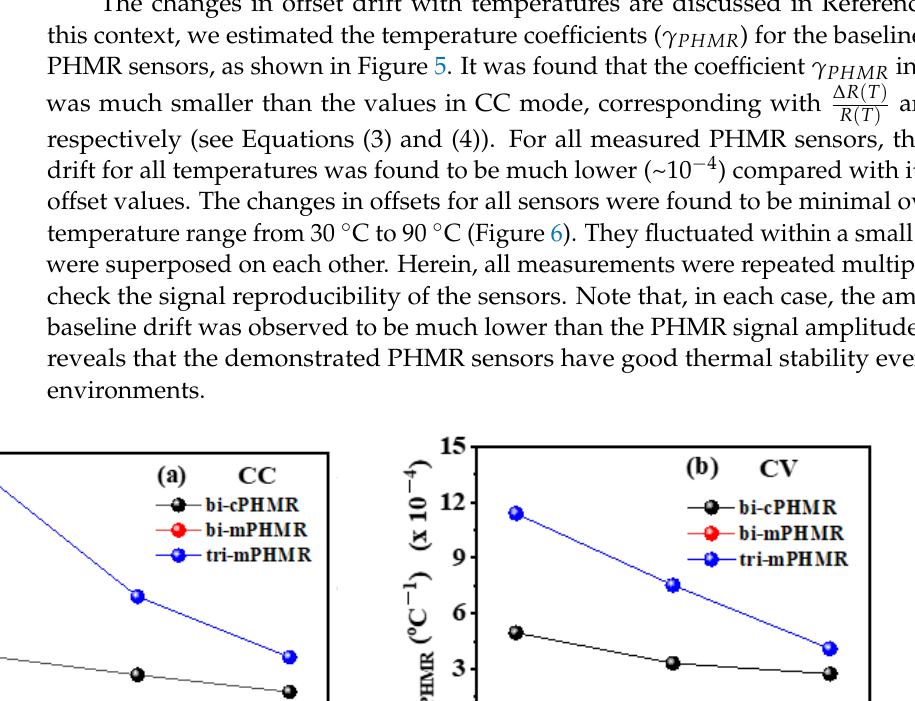
Figure 4. ( a – c ) Baseline offset drifts ( ∆ V Baseline ) with temperature change in CC and CV modes.